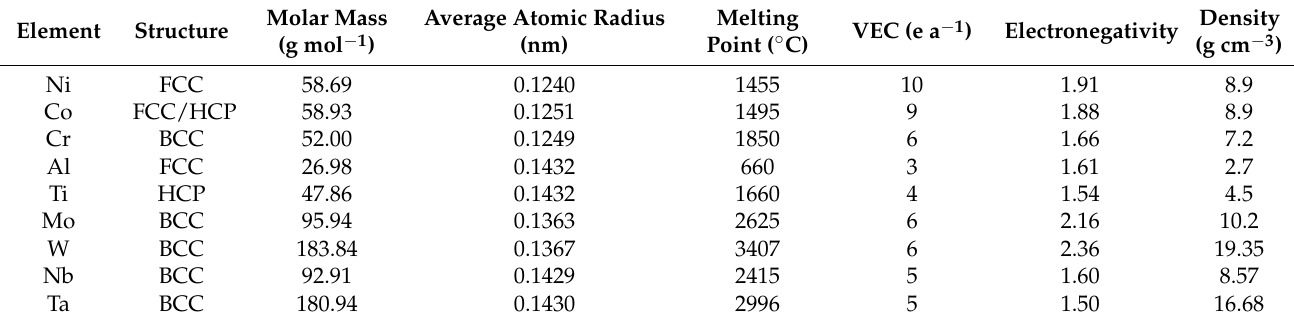
Table 2. Characteristic parameters of alloying